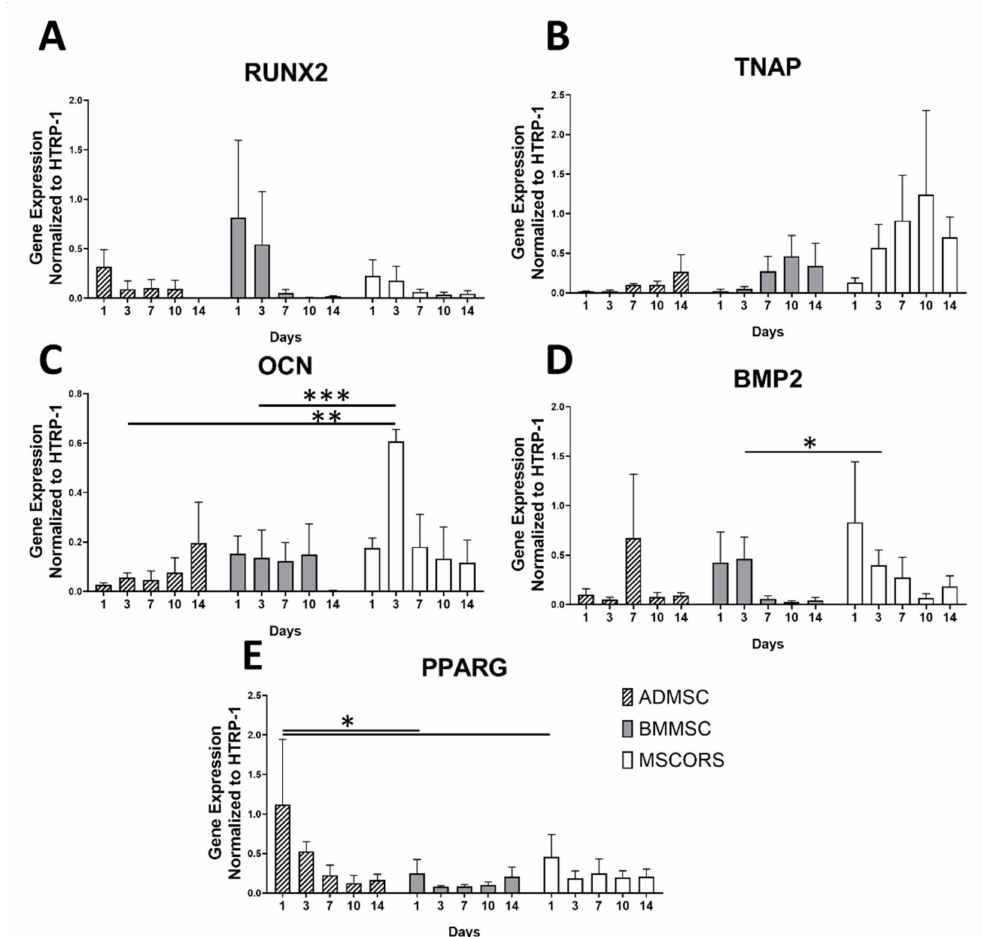
Figure 4. Gene expressions of osteogenic and adipogenic markers analyzed with qRT-PCR in ADMSCs, BMMSCs, and MSCORS during 3D differentiation in Osteogel, at day 1, 3, 7, 10, and 14 of differentiation. The analysis includes RUNX2 ( A ), TNAP ( B ), OCN ( C ), and BMP2 ( D ), and adipogenic gene PPARG ( E ). Relative expression levels were normalized to the housekeeping gene HPRT-1 and shown as mean ± SEM. Comparison of each group was statistically analyzed by the unpaired Student’s t-test or nonparametric Mann–Whitney test. Statistical significance: * p < 0.05, ** p < 0.01, *** p <